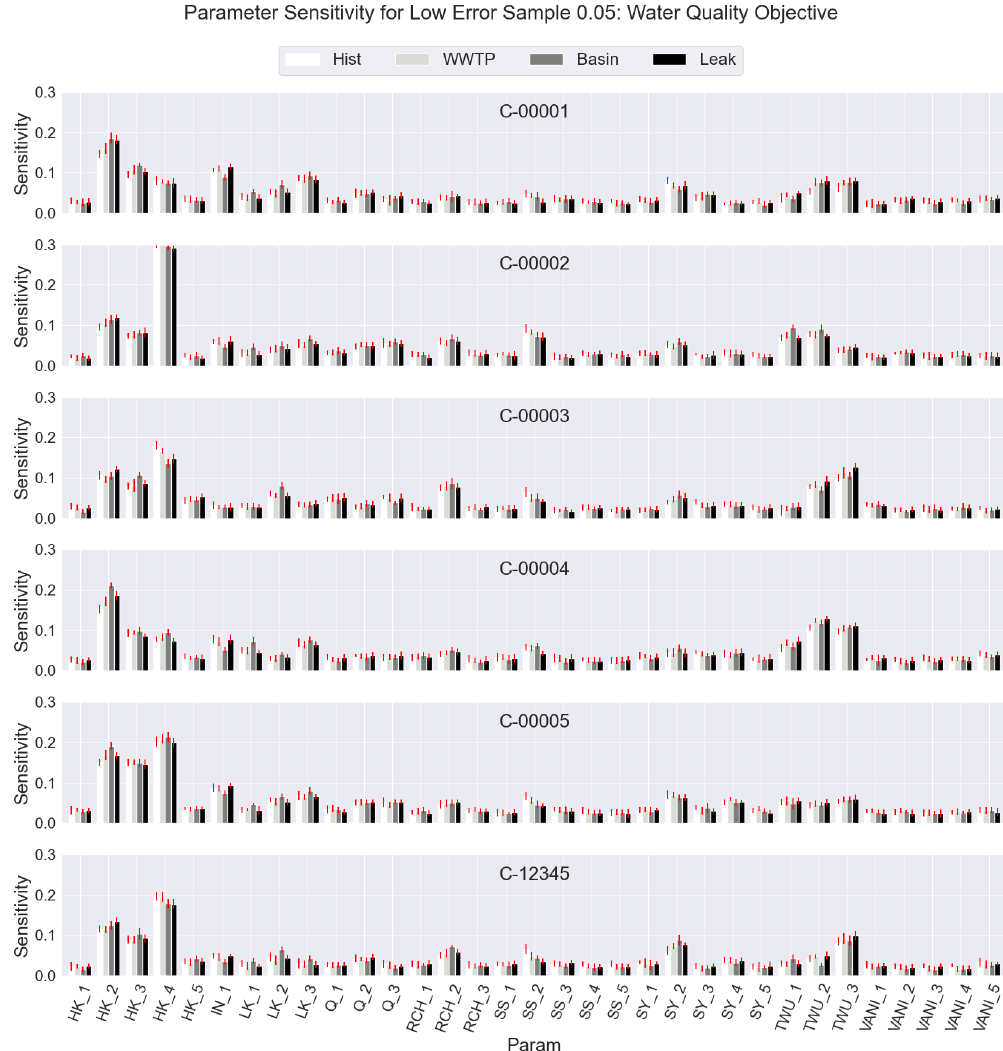
Figure A2. δ sensitivity of the water quality risk objective according to the 5000 filtered samples for the 33 model parameters (columns). The sensitivity is shown by cluster (rows) and by the four alternatives from left to right (light to dark), i.e., historical, wastewater reuse, infiltration basins, and repair